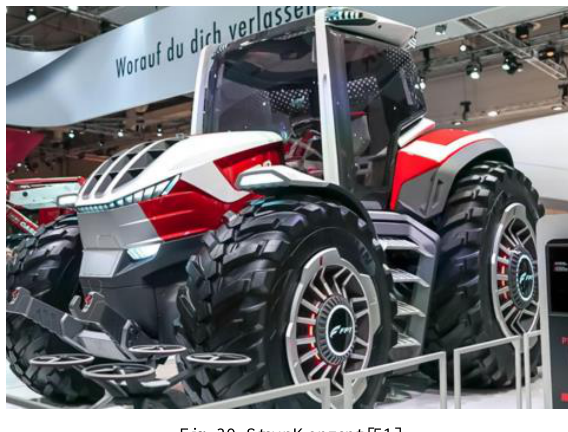
Fig. 39. Steyr Konzept